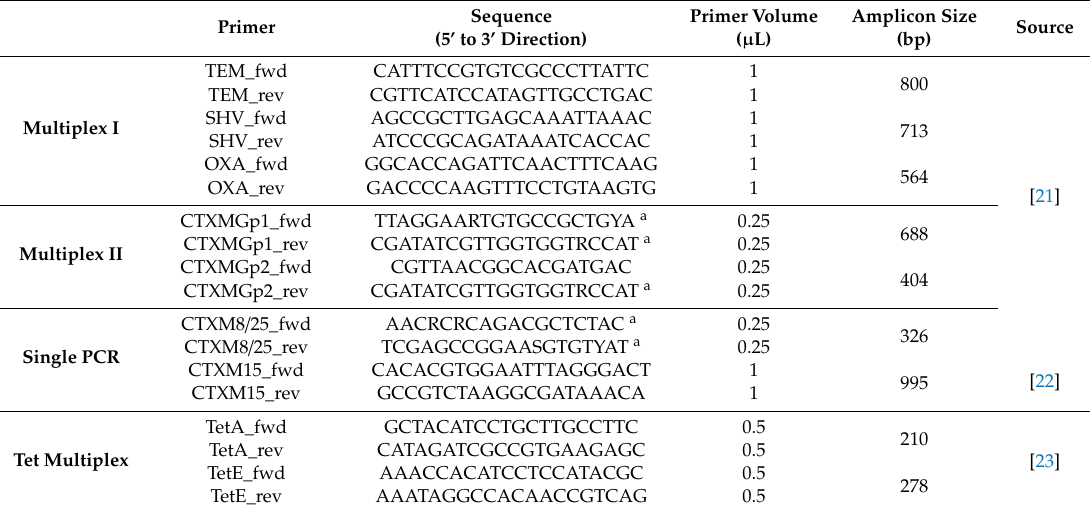
Table 2. Oligonucleotides used in this